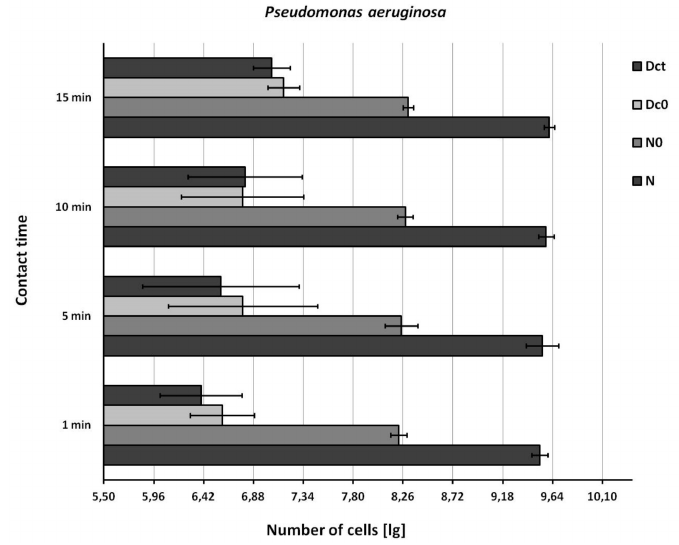
Figure 3. Recovery of Pseudomonas aeruginosa from the surface. N = density of test suspension (basic limit: 9.17 ≤ lg, N ≤ 9.70); N0 = density of the test suspension at the beginning of the contact time 0 (basic limit: 7.88 ≤ lg, N0 ≤ 8.40 ); Dc0 = drying control at the contact time 0 (basic limit: 6.88 ≤ lg, Dc0 ≤ 8.40); Dct = drying control at the end contact time t (basic limit: 6.88 ≤ lg Dct ≤ 8.40). Shown are means and standard